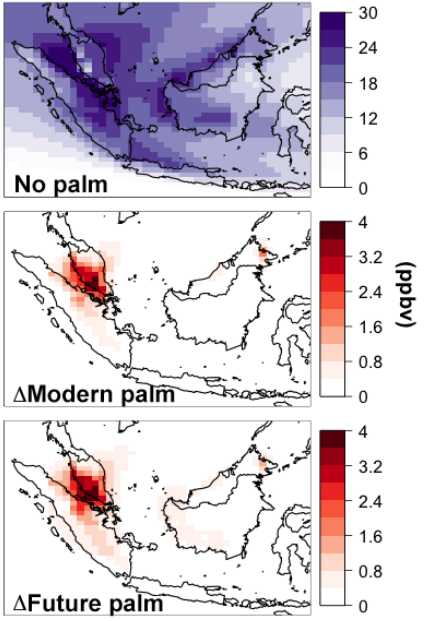
Figure 9. Annual average surface ozone concentrations over SEA (top) and the change due to Modern (middle) and Future (bot- tom) Palm